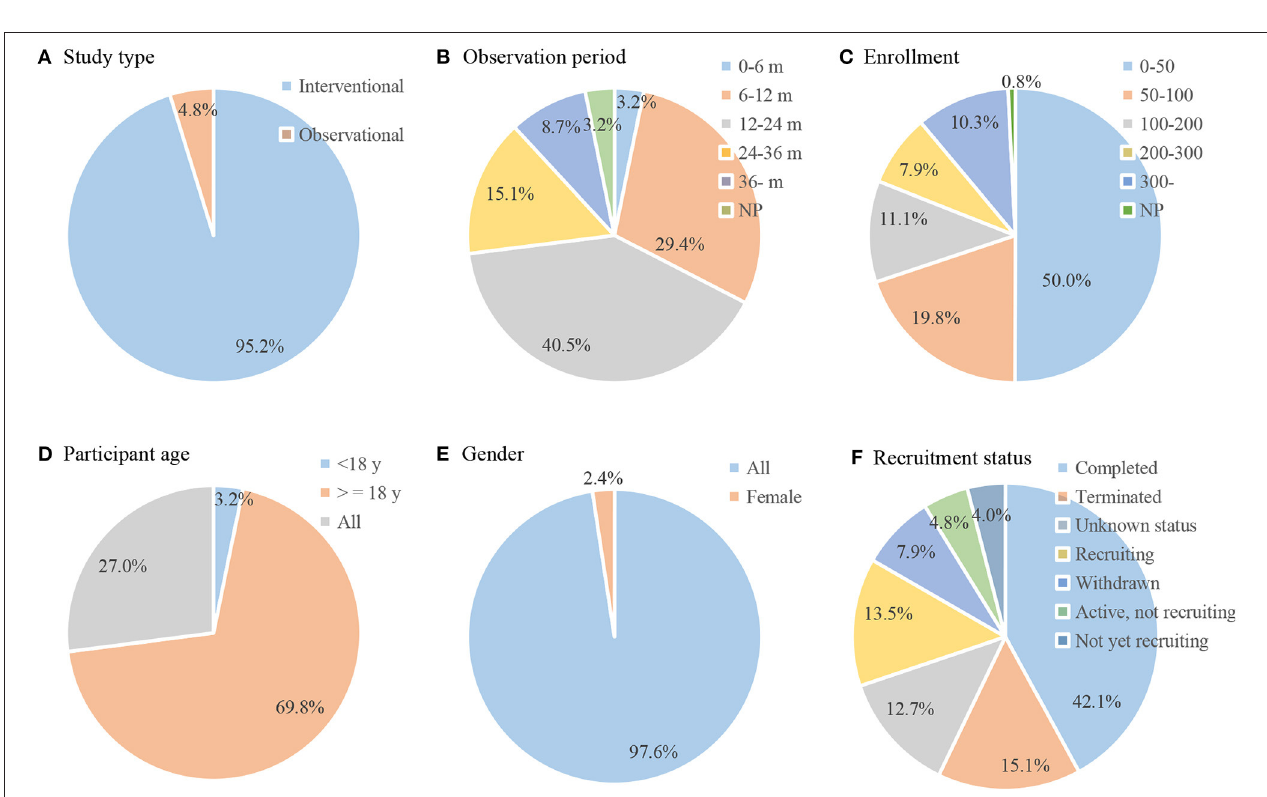
FIGURE 2 | General characteristic of included trials ( n = 126). Pie chart of (A) study type; (B) observation period; (C) enrollment; (D) participant age; (E) gender; (F) recruitment status.